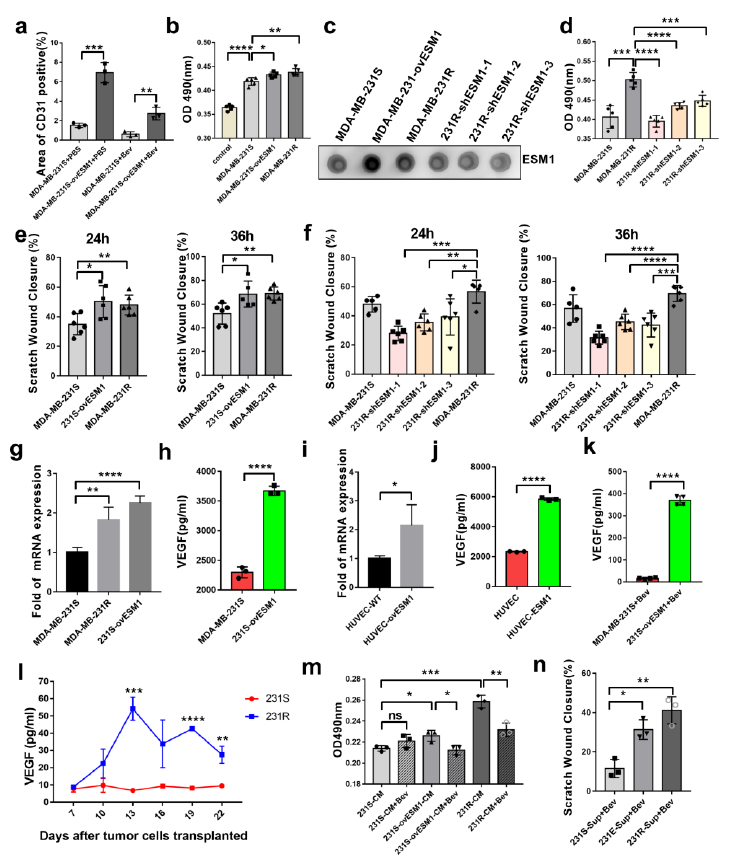
Figure 5. ESM1 promoted the proliferation as well as increased migration of HUVEC in vitro. ( a ) Immunofluorescence analysis of MDA − MB − 231 − S or MDA − MB − 231 − S ovESM1 tumor sections from mice treated with PBS or bevacizumab. *, p < 0.05; ** p < 0.01; *** p < 0.001, **** p < 0.0001, by t test. ( b ) HUVEC cells were incubated by conditioned medium of MDA − MB − 231 − S, MDA − MB − 231 − S ovESM1 or MDA − MB − 231 − R for 24 h and the survival was measured by MTT assay, * p < 0.05; ** p < 0.01; *** p < 0.001, by t test. ( c ) Dot blotting of ESM1 in MDA − MB − 231 − S, MDA − MB − 231 − S ovESM1 ,